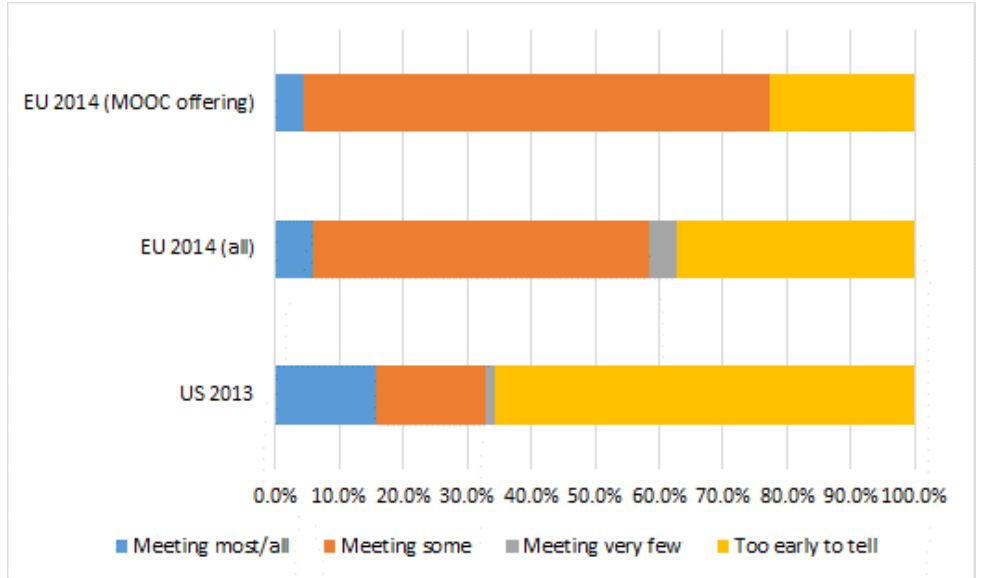
Figure 6. How well are MOOCs meeting institution's